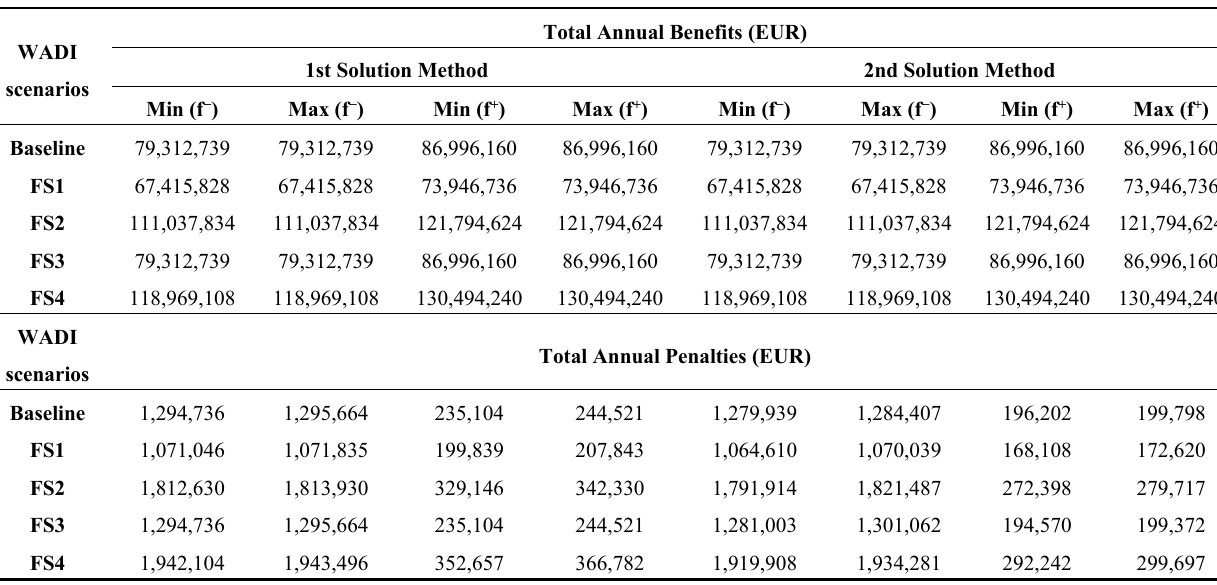
Table 11. Total annual benefit and penalties (EUR) for hydropower production at Flokas HPS.